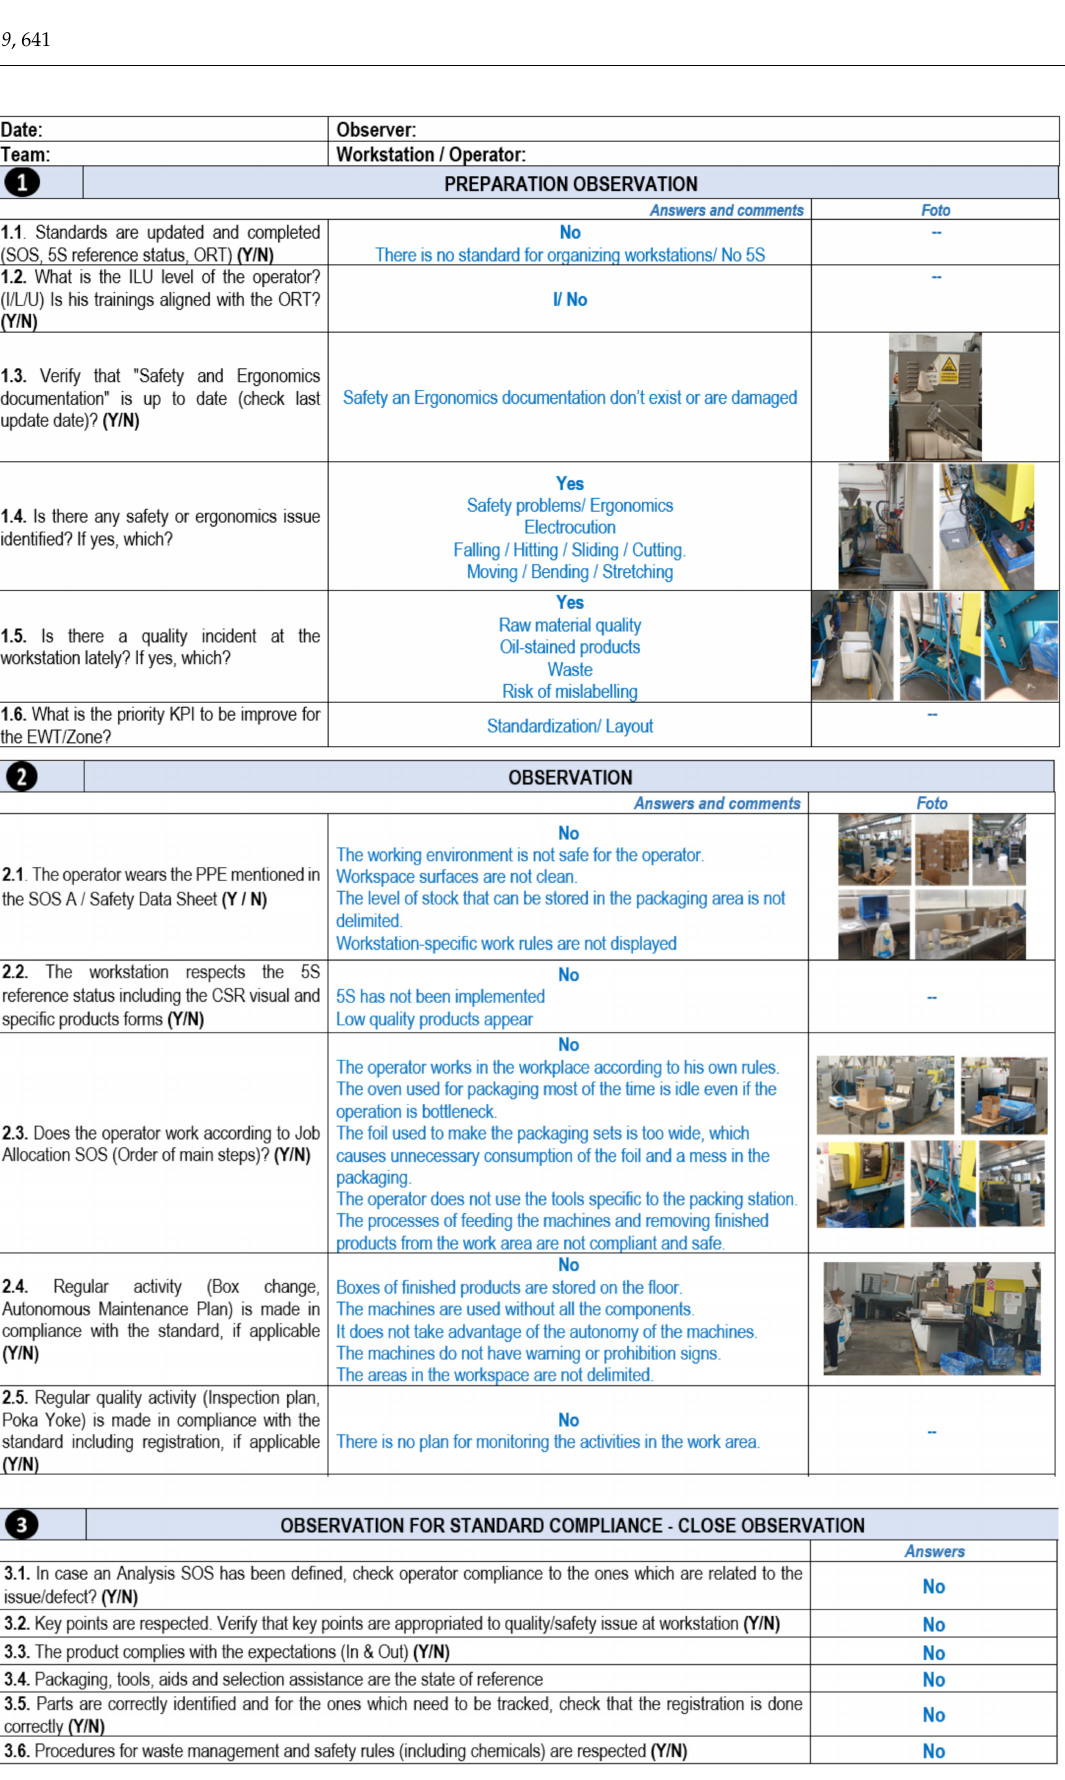
Figure 17. JobObservation questionnaire of the production system “plastic